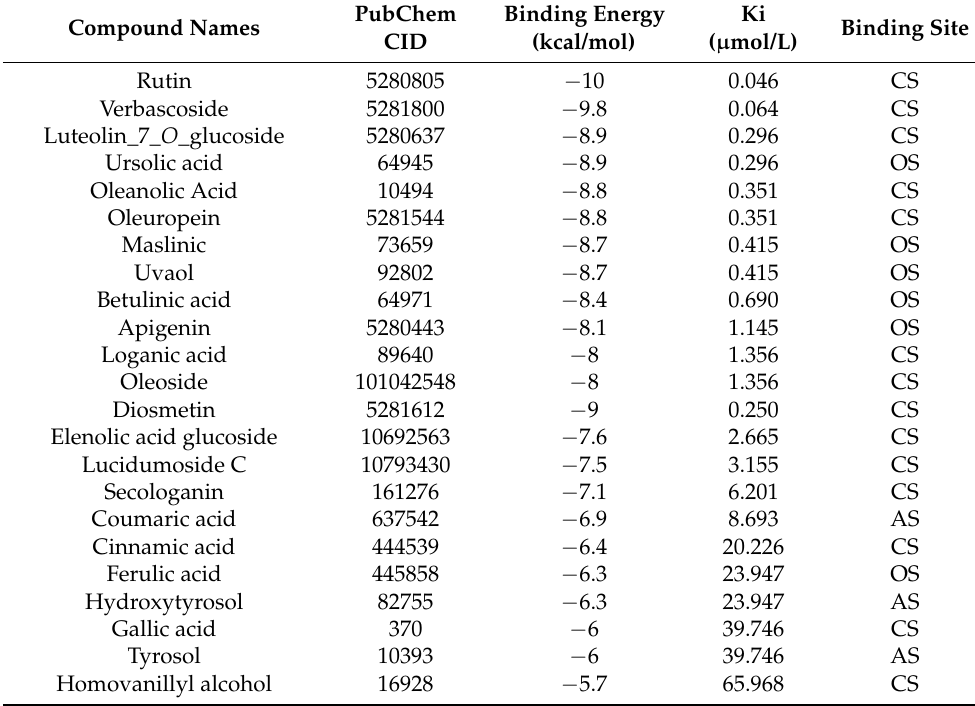
Table 5. Screening of the phytocompounds to obtain potential lead molecules (bold) based on their respective binding energy profile upon docking with PKM2 using Autodock